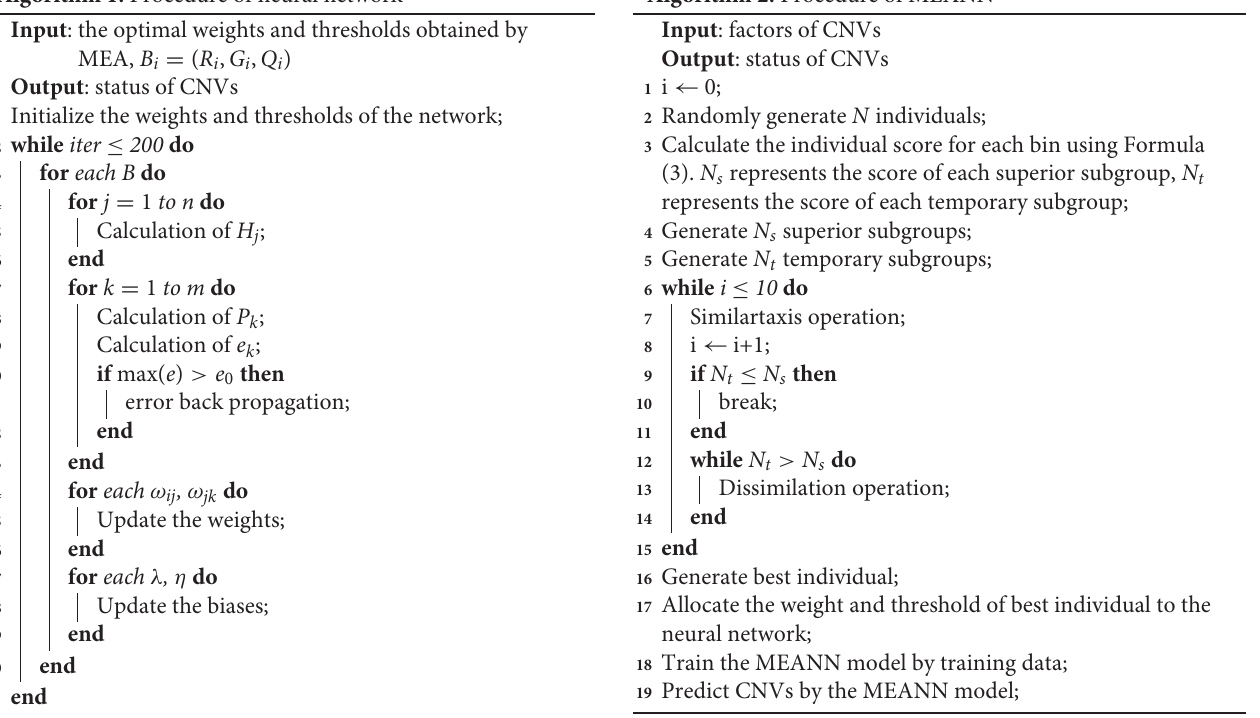
Algorithm 1: Procedure of neural network Algorithm 2: Procedure of